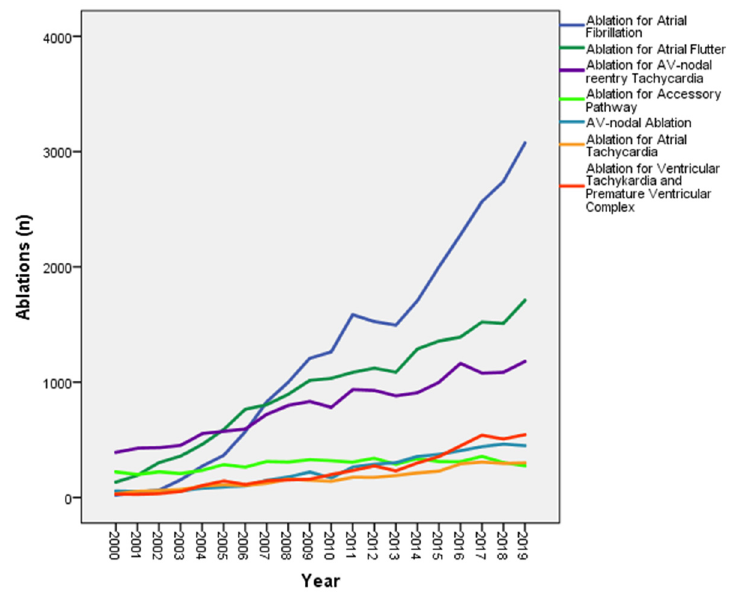
Figure 1. Number of ablations distributed by type of ablation from 2000 till the end of 2019. Table 1. Relative ablation numbers to the yearly population of Switzerland 2000–2019.